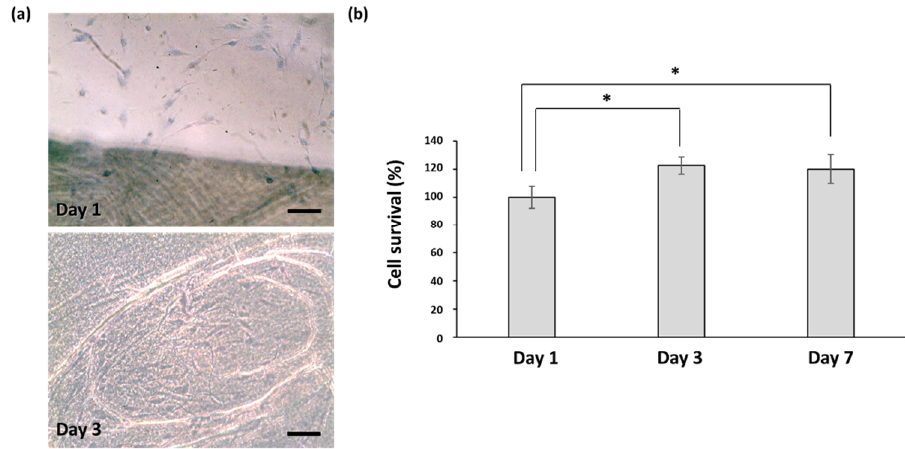
Figure 2. Study of in vitro biocompatibility of bacterial cellulose scaffold incubated with human adipose stem cells (hASCs) using trypan blue staining. ( a ) Growth of hASCs with time. ( b ) Quantification of cell survival (scale bar = 200 μm; * p < 0.05) .